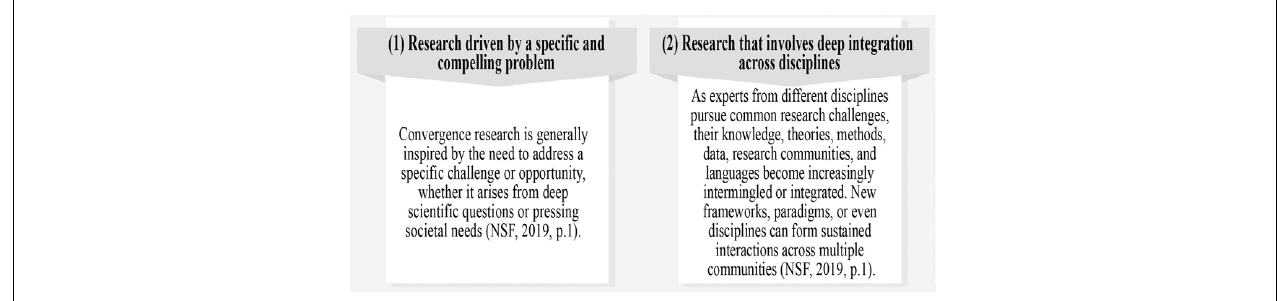
FIGURE 1 | Primary characteristics of convergence